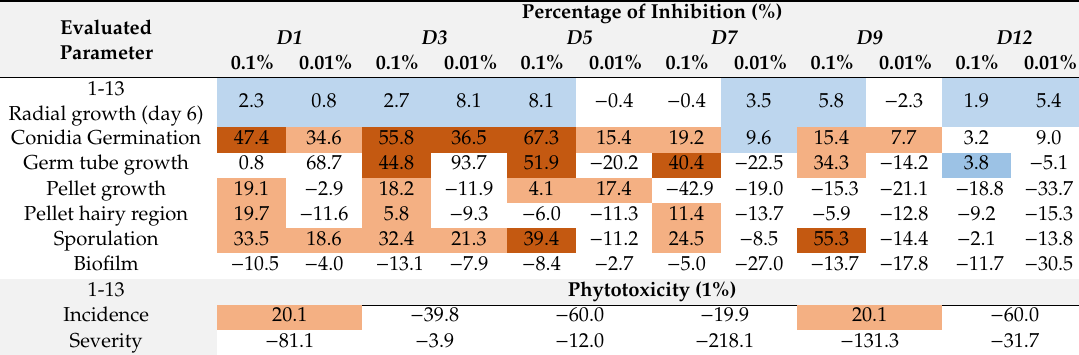
Table 3. Inhibitory activity of B. cinerea extracts on its growth.